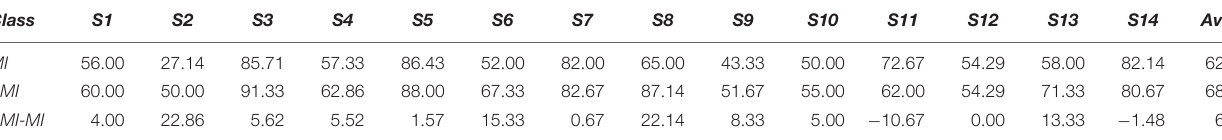
TABLE 1 | Classification accuracy in the motor imagery (MI) and somatosensory-motor imagery (SMI) conditions.